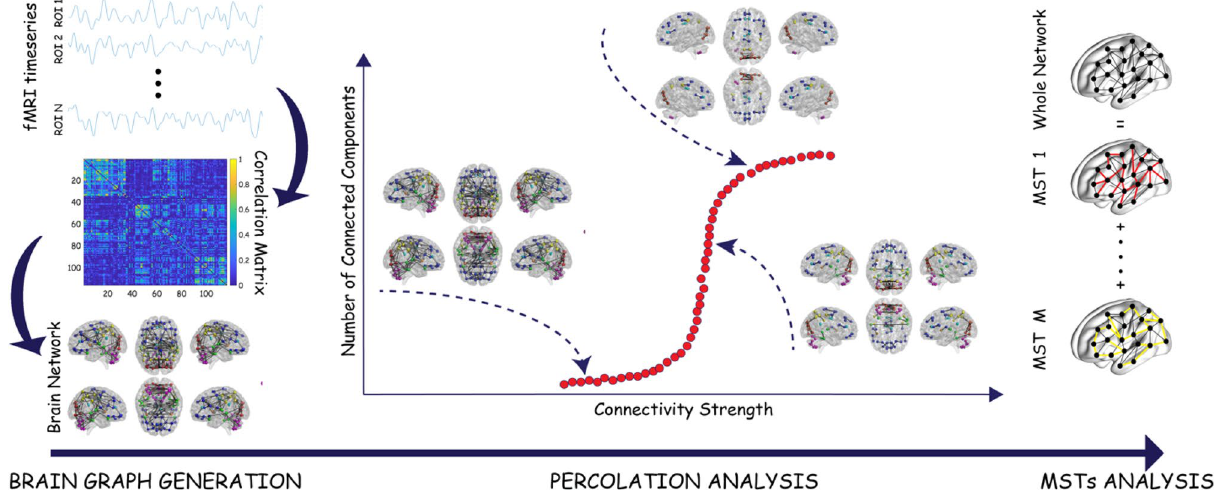
Figure 1. Flowchart of the network analysis. The temporal progression of the network analysis can be divided into three main parts: the network construction from BOLD time-series averaged in the regions of interest of the AAL atlas, the percolation analysis that highlights the integration process of the network’s nodes into modules according to the strength of their connectivity and finally the unpacking of the whole brain graph in terms of Maximum Spanning Trees (MSTs) that allows one to identify deviations from the hierarchical organization of the